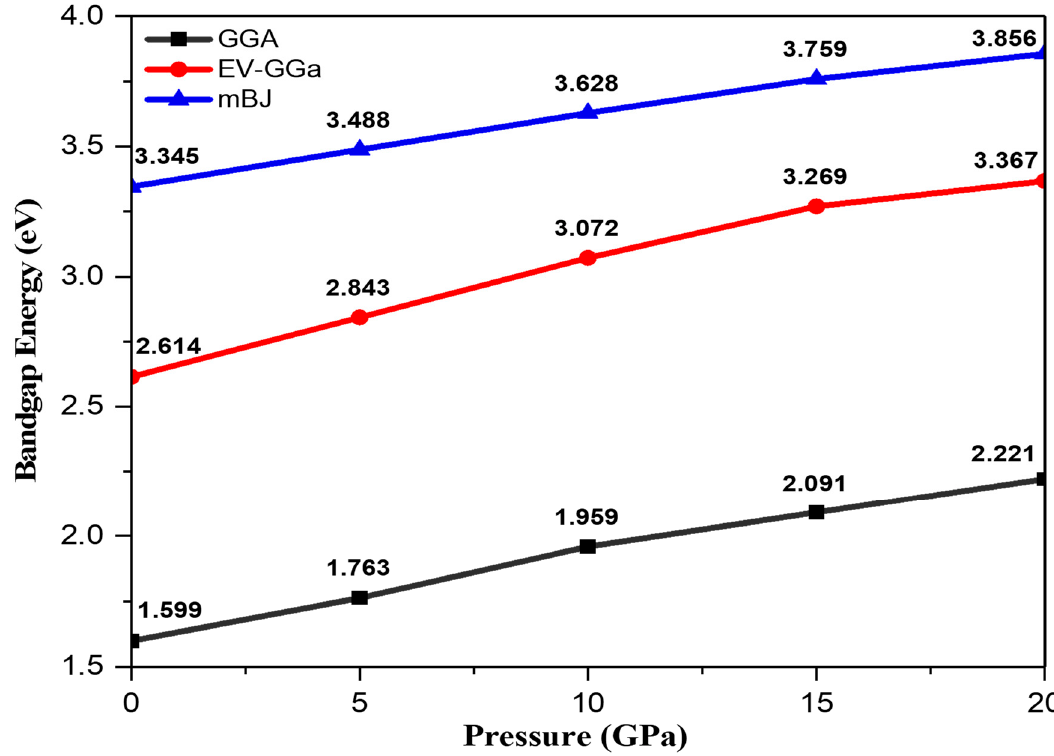
Figure 1. Bandgap variation as a function of pressure ranging from 0 to 20 GPa.